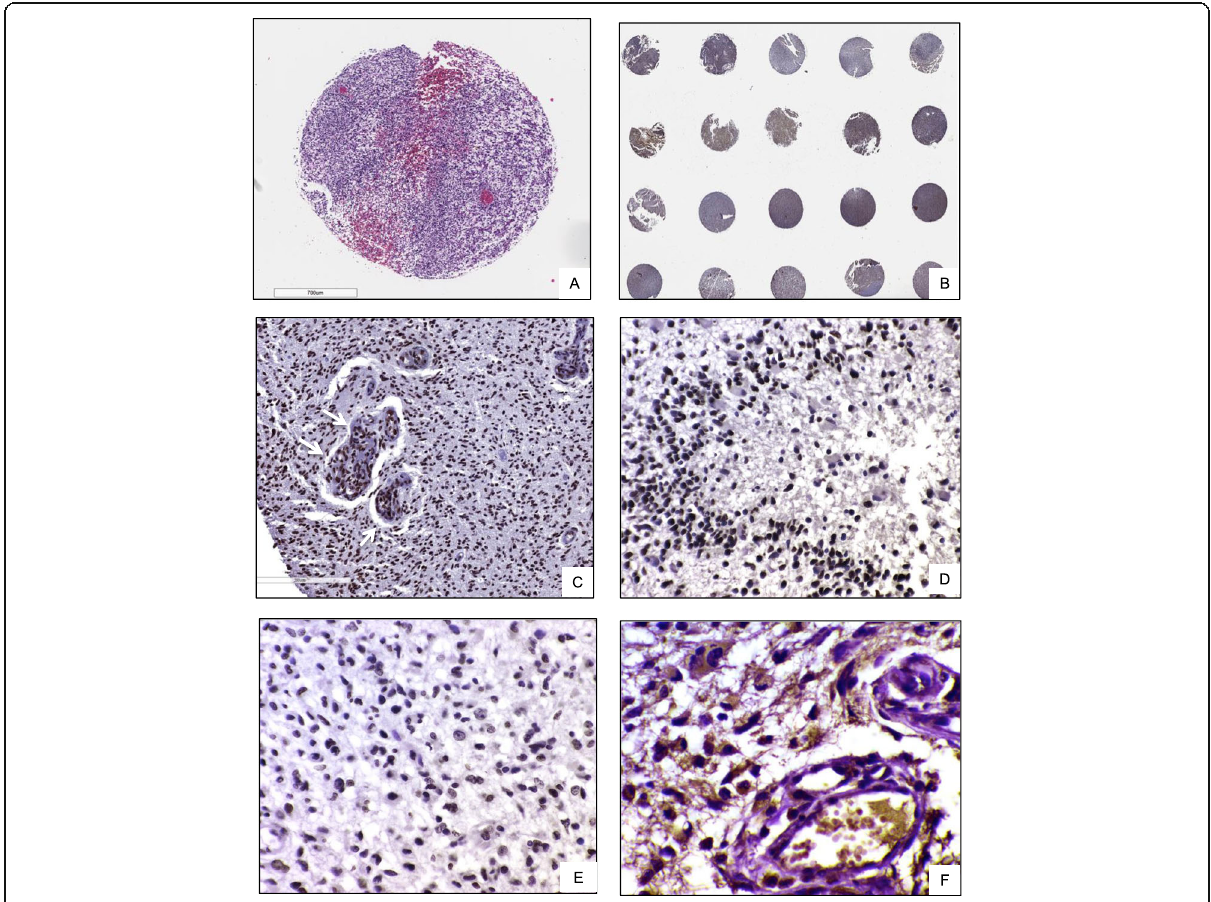
Fig. 1 Morphological and immunohistochemical features of VEGF-C and – D in GBM tissue microarray (TMA) sections. A ) Cylindrical core of 2-mm from a representative GBM area (H&E, × 100). B ) TMA design in a 4-um tissue section used for VEGF-C immunostaining (lower magnification). C to